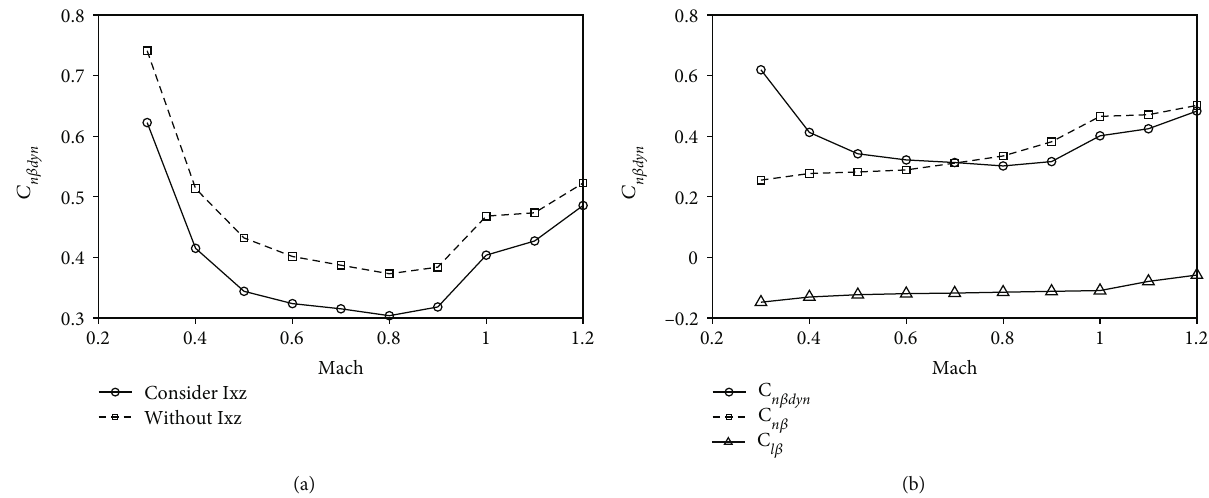
Figure 3: Lateral – directional stability parameter with respect to Mach number (at the reference CG position). (a) Analysis of C and without I . (b) C , C , and C with respect to Mach numbers. xz n β dyn n β l β